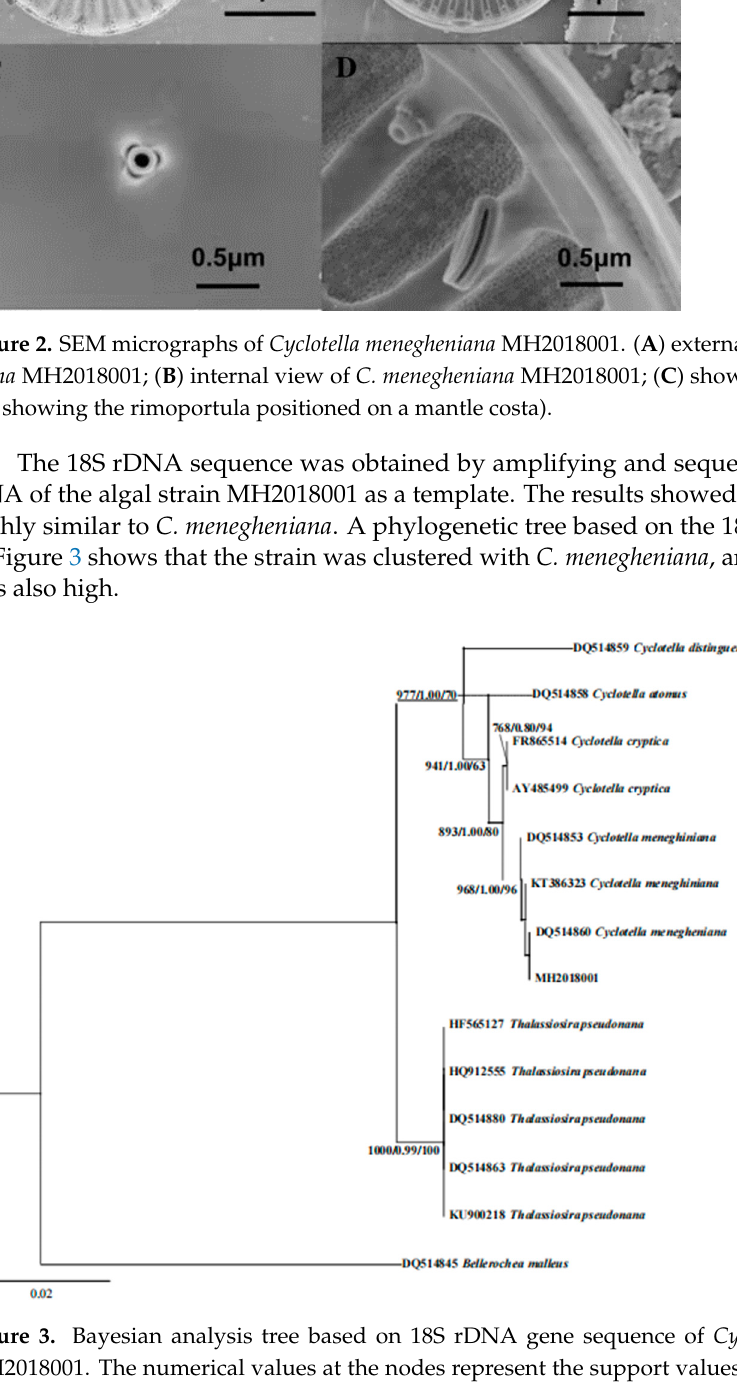
Figure 1. Cyclotella menegheniana MH2018001 (( A , B ) light micrographs; ( C ) fluorescence micrographs).